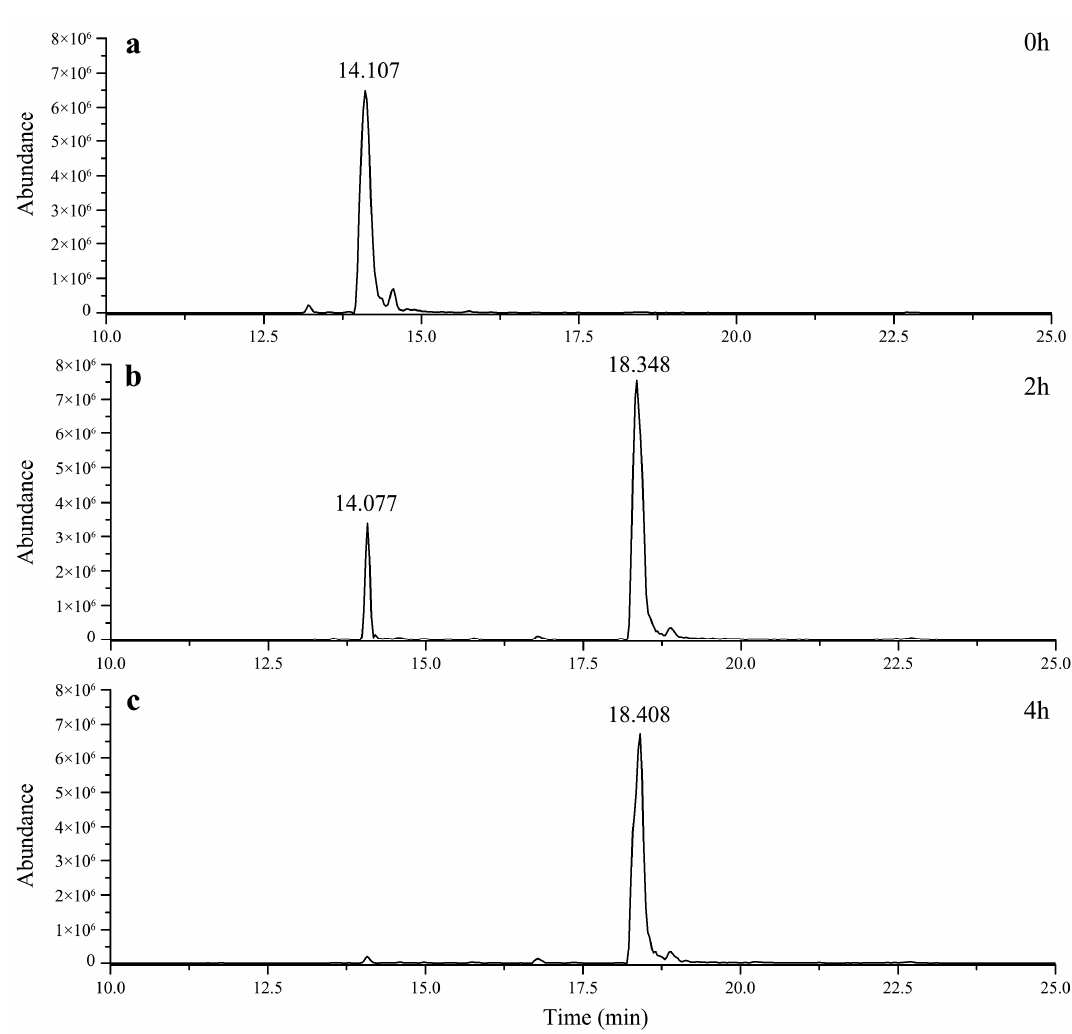
Figure 2. Total ion chromatograms for the enzymatic transformation of gypenoside XLIX by using the recombinant enzyme for 0 h ( a ), 2 h ( b ) and 4 h ( c ).